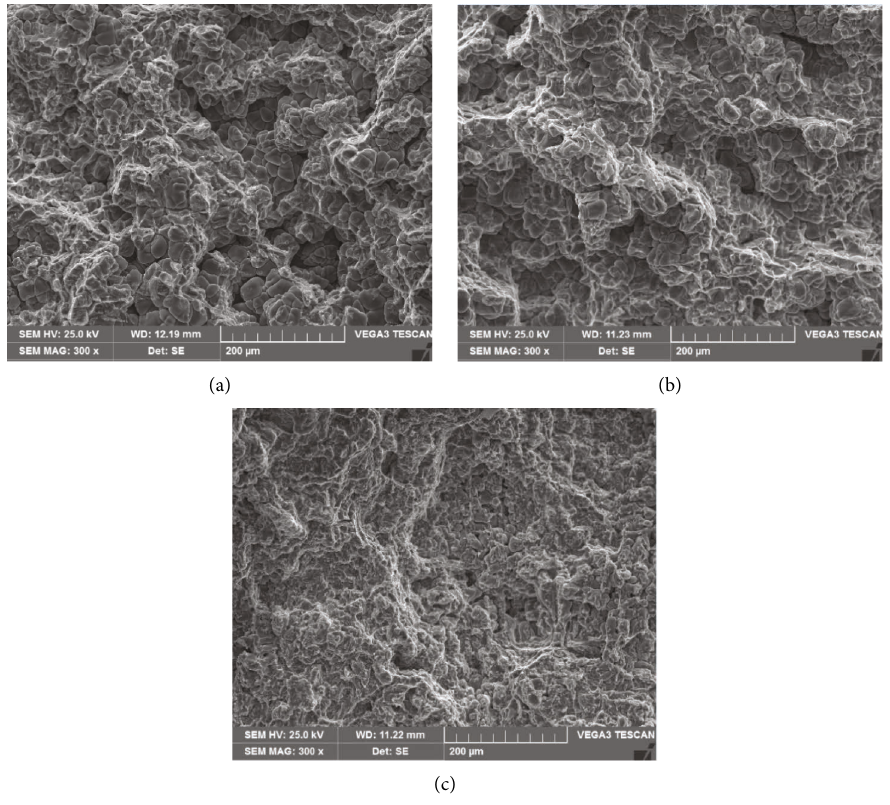
Figure 12: Tensile fractured surfaces of (a) as-cast Al7075, (b) Al7075-3 wt% TiC, and (c) Al7075-6wt% TiC